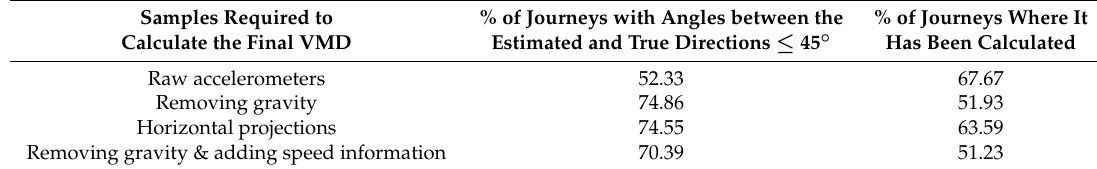
Table 6. Comparison of performances in VMD estimation when we require 60 or more